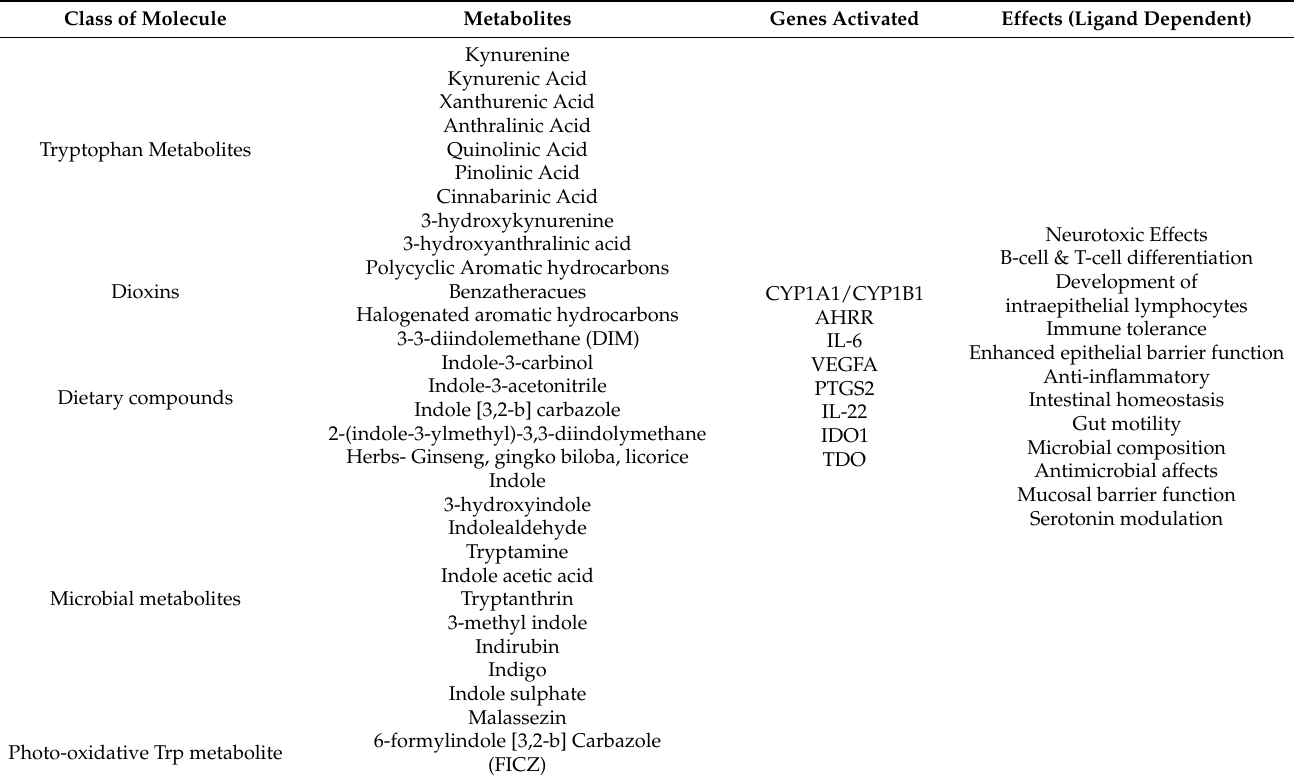
Table 1. Classes of Ahr